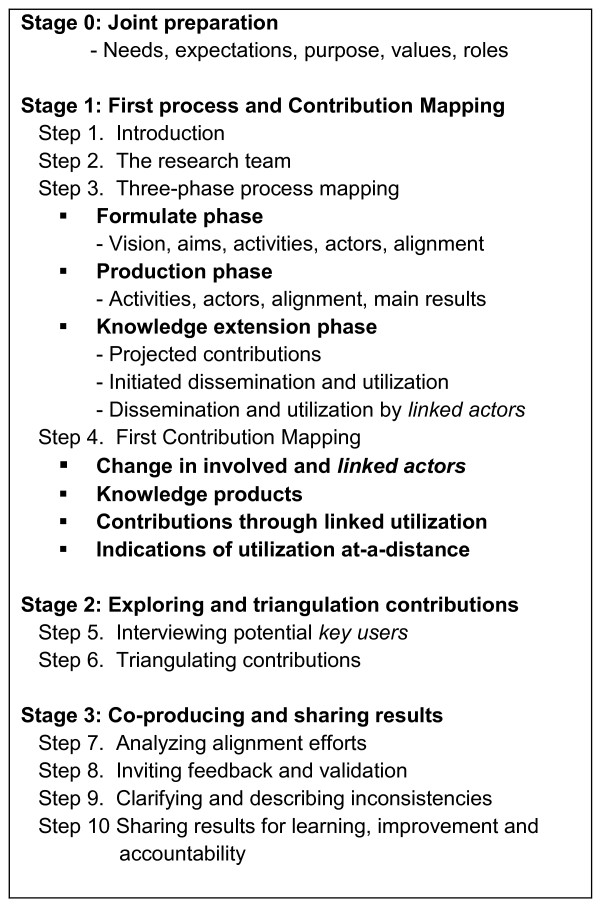
Stages and steps inContribution Mapping.